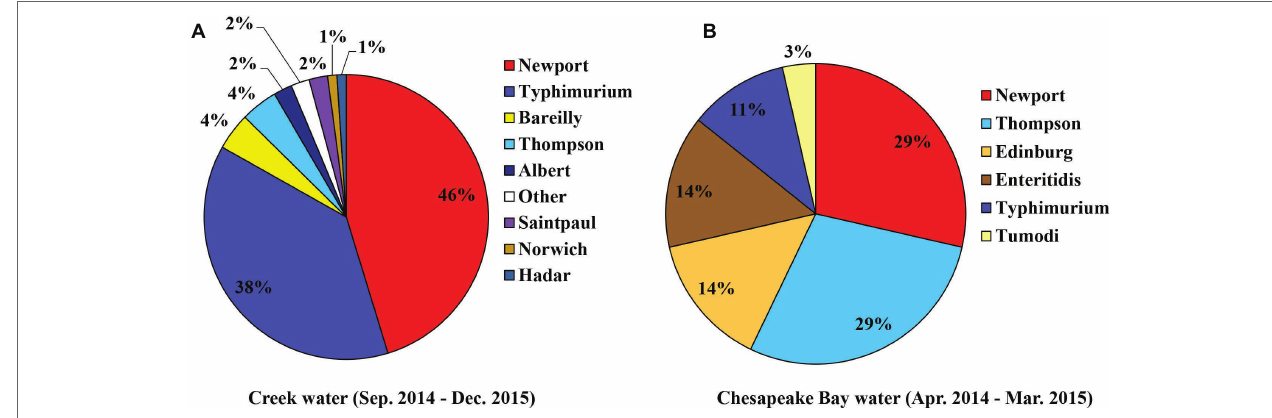
FIGURE 3 | Diversity of S. enterica serovars isolated from sampled creek water [ (A) , n = 95] and Chesapeake Bay water [ (B) , n = 27].